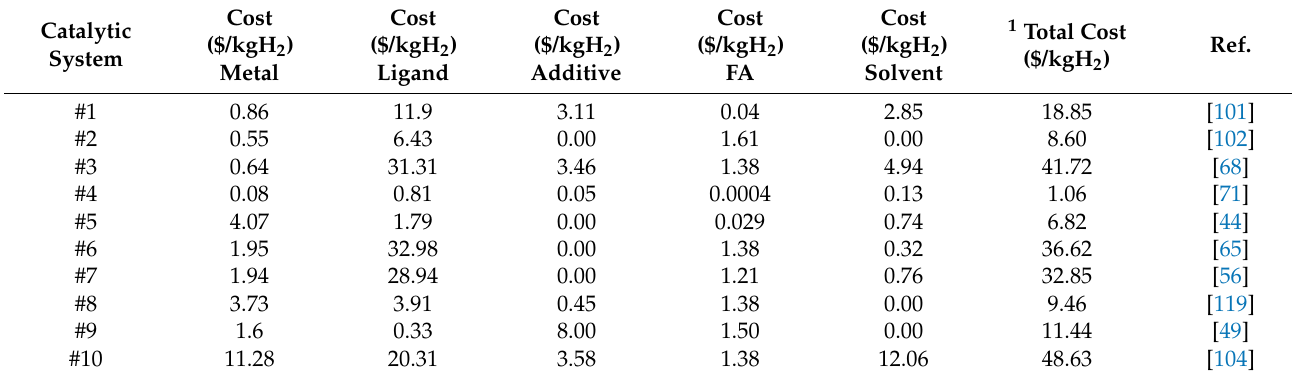
Table 5. Cost assessment of selected catalytic